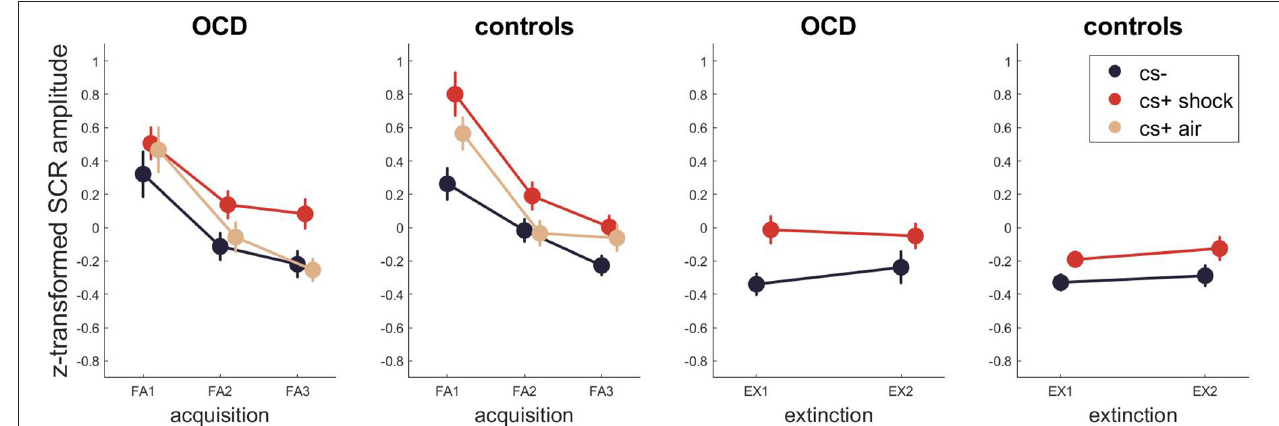
FIGURE 2 | SCR across fear acquisition and extinction. Error bars are standard errors of the mean.